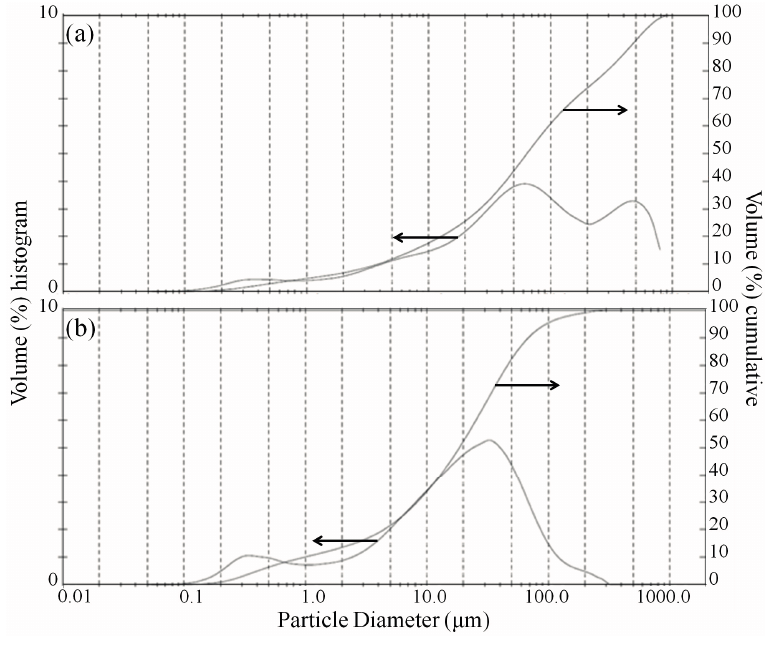
Figure 5. ( a ) Particle size distribution of fresh olivine after bioleaching with Aspergillus niger without ultrasonic conditioning; and ( b ) with ultrasonic